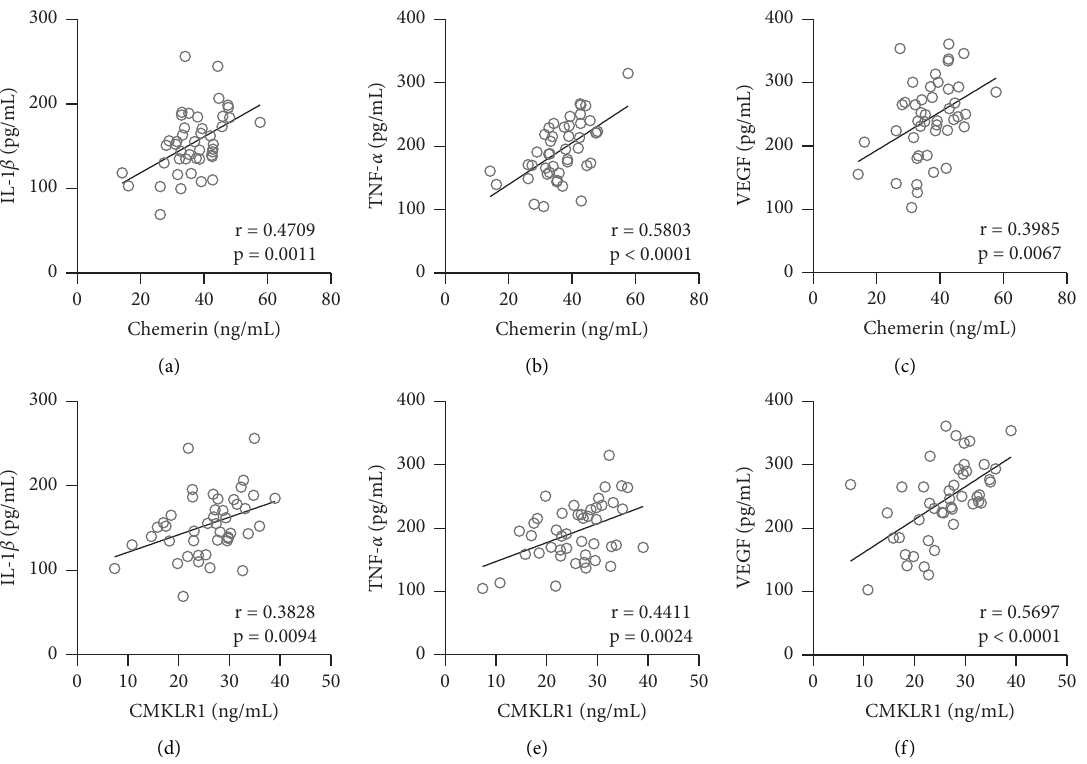
Figure 3: Pearson correlation coefficient of serum chemerin and IL-1 β (a), TNF- α (b), and VEGF (c); serum CMKLR1 and IL-1 β (d), TNF- α (e), and VEGF (f) in PDR